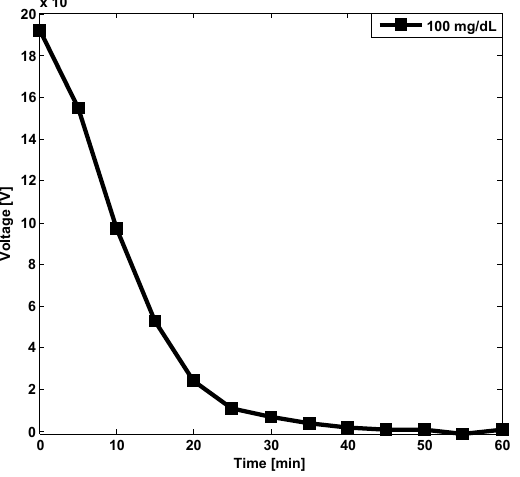
Figure 5. The output voltage is decreased when the 100 mg/dL glucose concentration is introduced in the test